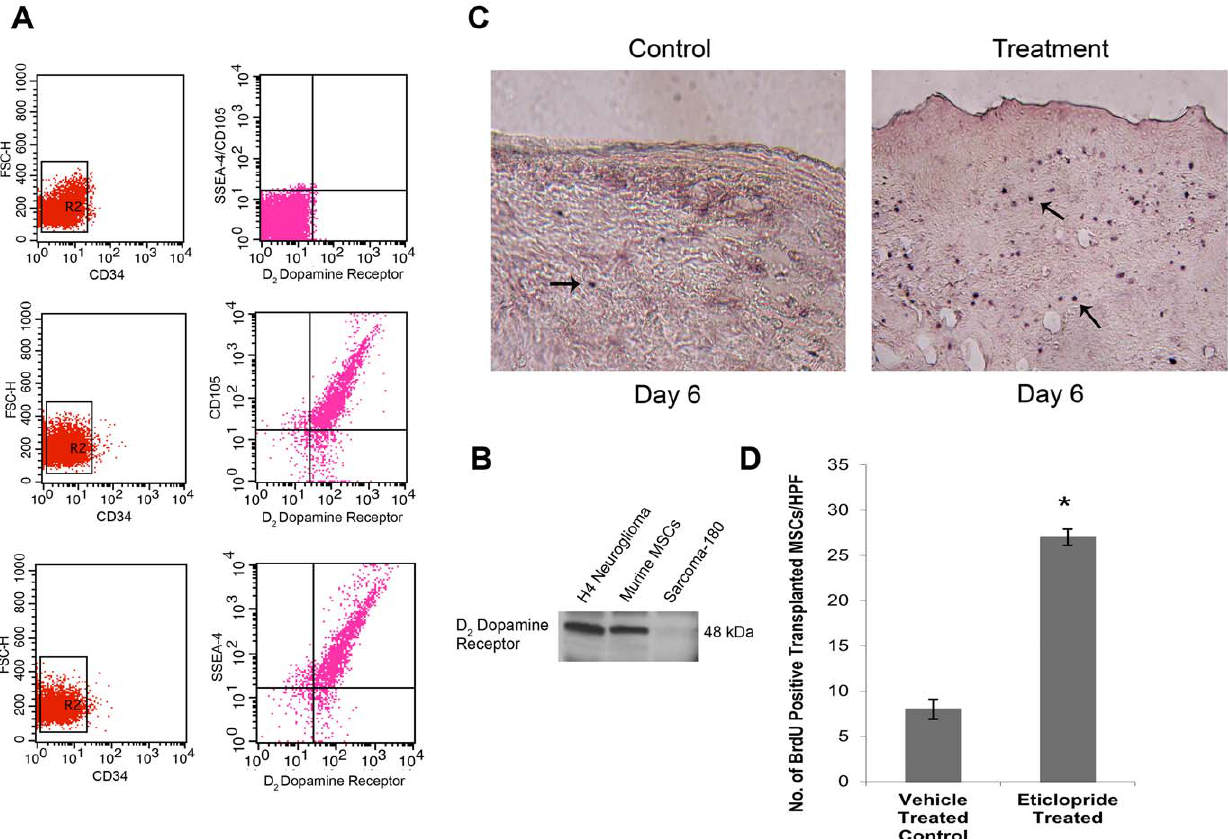
Figure 2. Treatment with dopamine (DA) D 2 receptor antagonist significantly accelerated mobilization of exogenously transplanted MSCs towards wound bed. ( A ) Flow cytometric analysis of DA D 2 receptors in murine MSCs. To confirm that CD34 2 CD45 2 CD105 + SSEA-4 + cells express DA D 2 receptors, in vitro expanded Lin neg bone marrow cell population (containing CD45 2 , CD11b 2 cell populations) were initially gated to exclude dead cells and debris and then the CD34 2 cell population were selected and these CD34 2 CD45 2 cells were evaluated